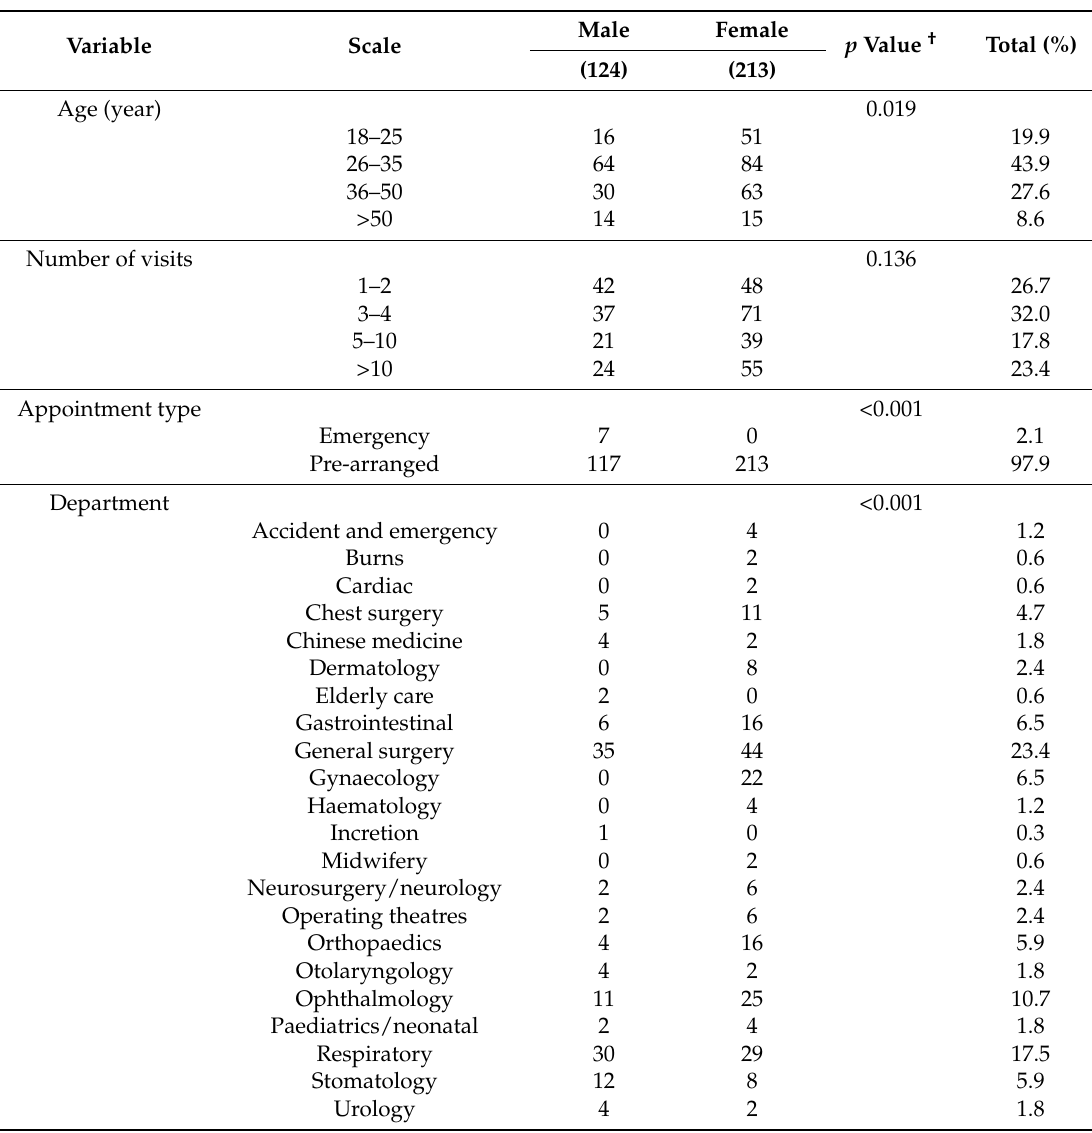
Table 1. Demographic information of the